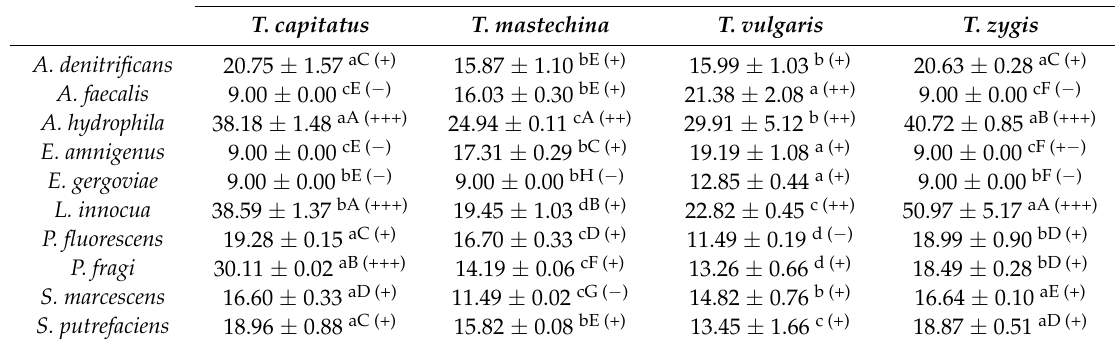
Table 4. Antibacterial activity of T. capitatus , T. mastechina , T. vulgaris and T. zygis EOs against several bacterial strains using a dry-cured sausage extract as culture